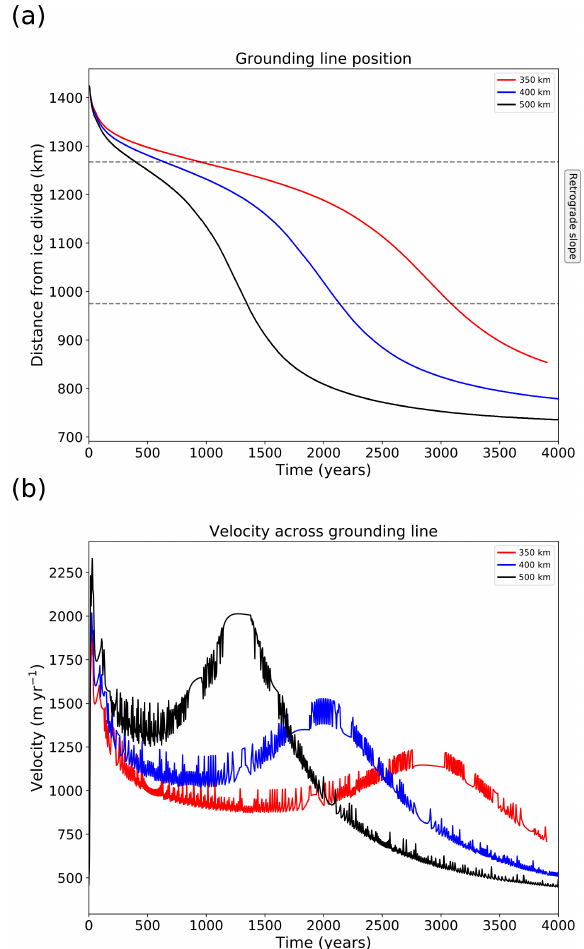
Figure 3. Evolution of (a) grounding line position and (b) cross- grounding-line sliding speed for a range of parameterised channel half-widths using the Weertman sliding